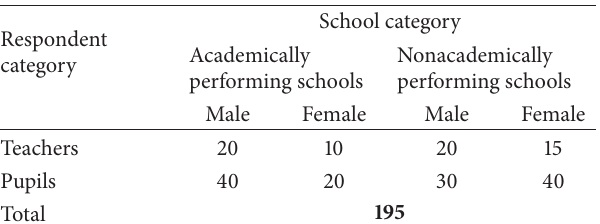
Table 2: Sample size